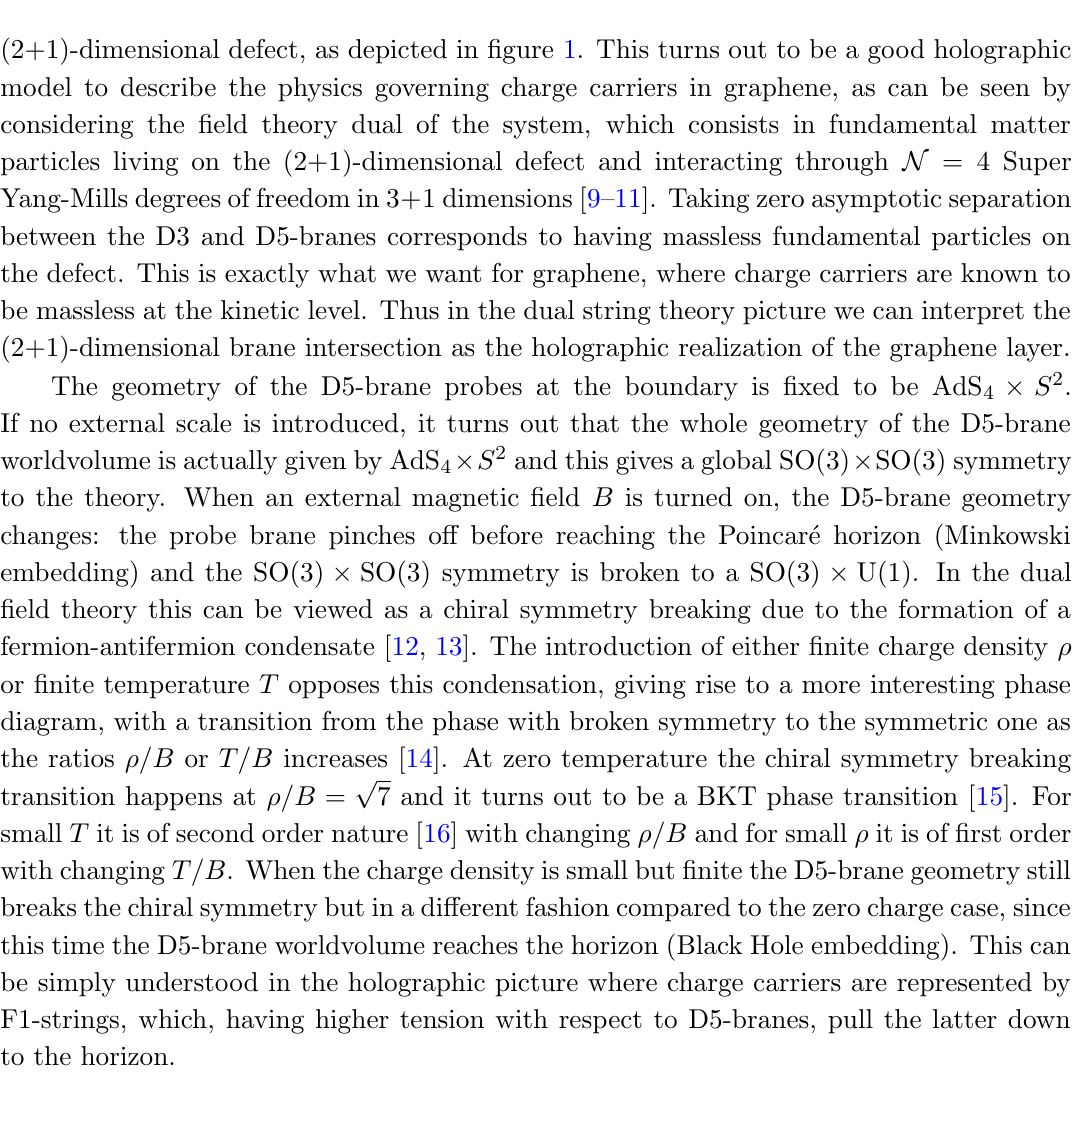
Figure 1 . Illustration of the D3/probe-D5-brane